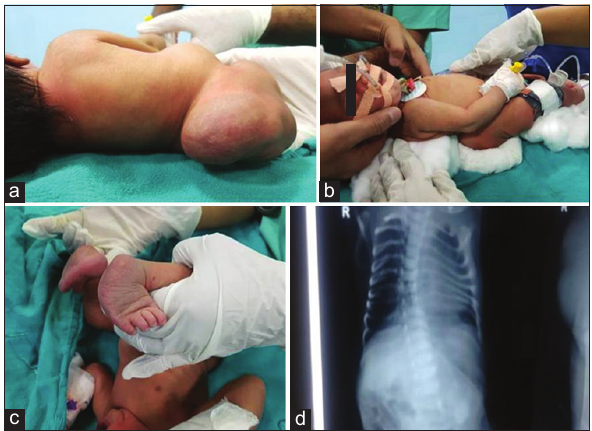
Figure 1: The neonate with OEIS: MMC (a); positioning during surgery over doughnut (b); club foot (c); and kyphoscoliosis